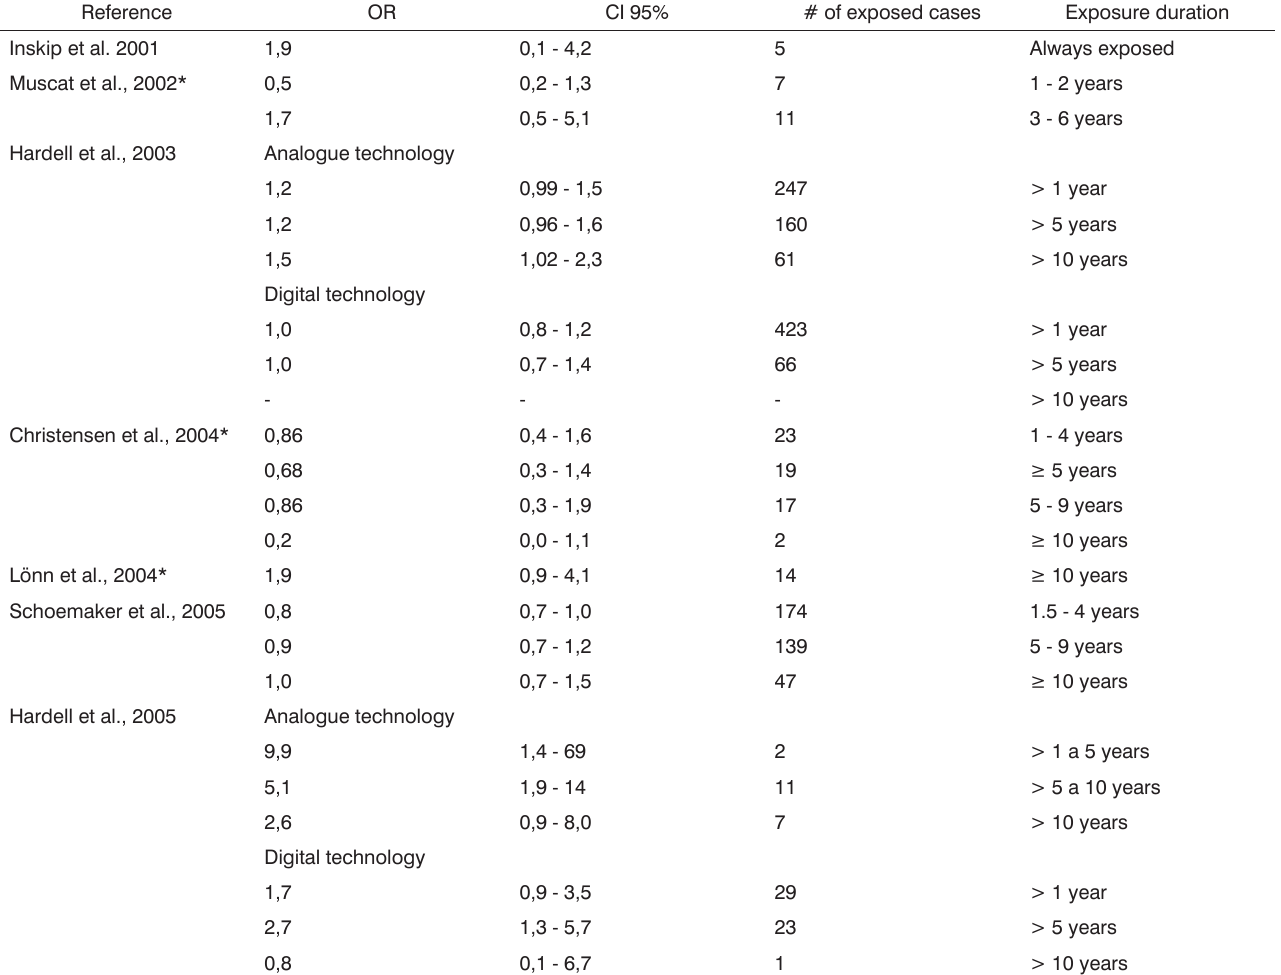
Table 5. Results and number of cases exposed in the investigations carried out in relation to the risk factor - cell phone - for vestibular nerve